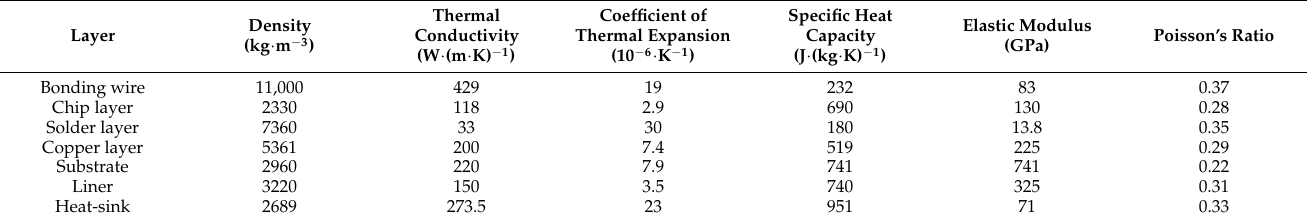
Table 4. Material properties of each layer.